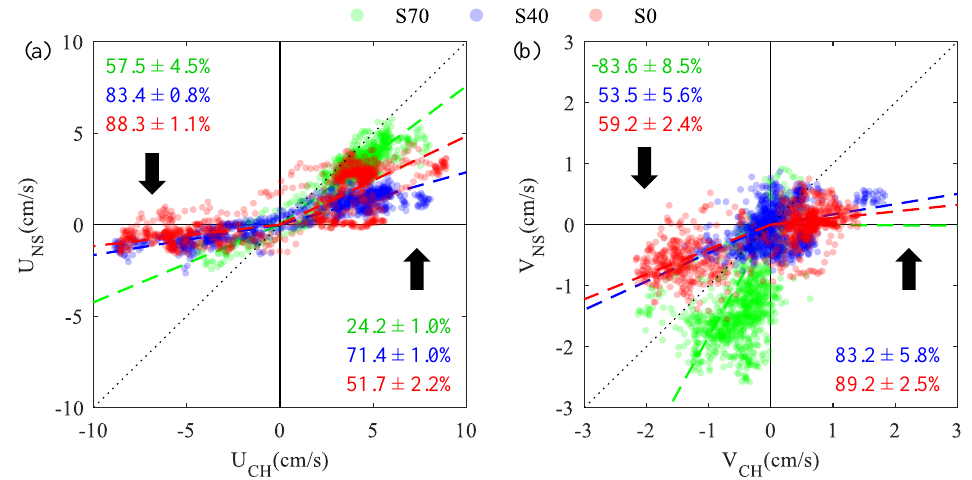
Figure 3. Channel-to-shore velocity attenuation for streamwise ( a ) and cross-shore ( b ) velocities measured at S70 (green), S40 (blue), and S0 (red). Colored lines show best-fit slopes between nearshore and channel measured velocities, and labels represent 95% CI on statistically significant ( p < 0.05) velocity attenuation estimates.